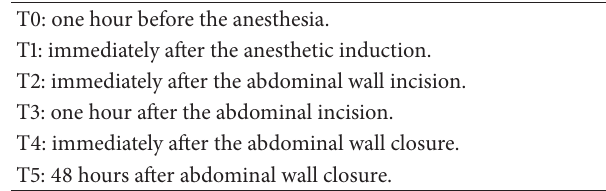
Table 1: Timing of blood